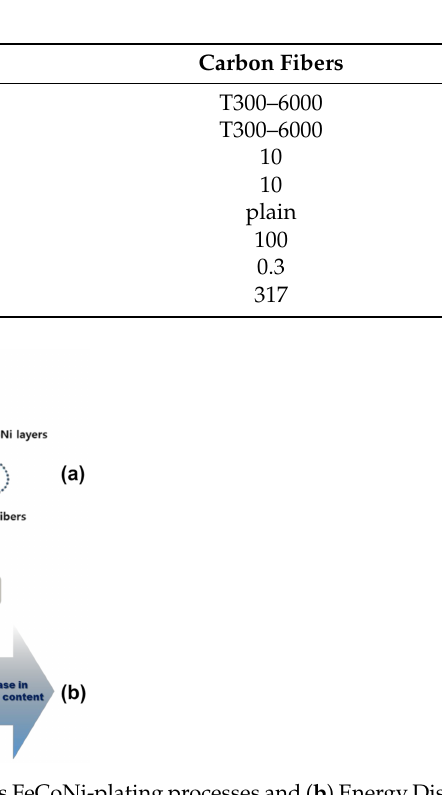
Figure 1. ( a ) Schematic diagram of the electroless FeCoNi-plating processes and ( b ) Energy Dispersive X-ray Spectroscopy (EDS) results and images based on pictures according to plating